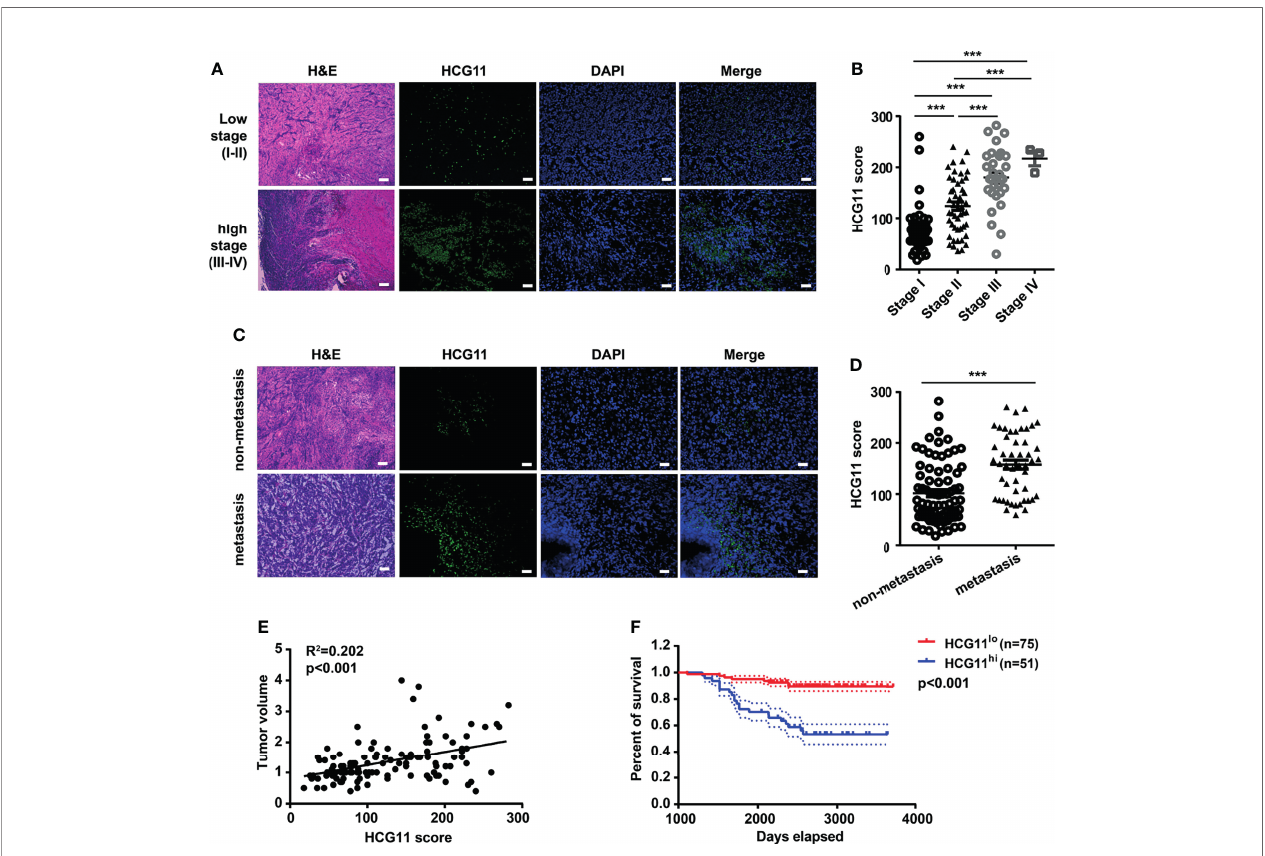
FIGURE 2 | High-expressed HCG11 is associated with poor prognosis in NPC. (A – D) H&E staining, FISH, and quantitative analysis of HCG11 expression in the NPC tissues with low stage (stage I, n = 45; stage II, n = 48), high stage (stage III, n = 30; stage IV, n = 3) (A, B) and also non-metastasis (n = 77) and metastasis (n = 49) (C, D) .Scale bar, 20 m m. (E) Correlation between HCG11 expression and tumor volume was performed in NPC tissues. (F) Survival curve of NPC patients with different HCG11 levels (low HCG11, n = 75; high HCG11, n = 51) was shown. Data were presented as Mean ± SEM. ***p <